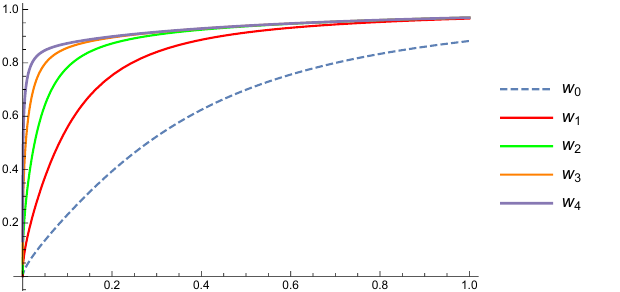
Figure 8. The graphics of recurrence generated adaptive functions from family (18). The one-sided Hausdorff distance d between cumulative distribution function w i ( t ) ( t ) satisfies the following nonlinear equation i = 1, 2, . . . and the Heaviside function h t 0